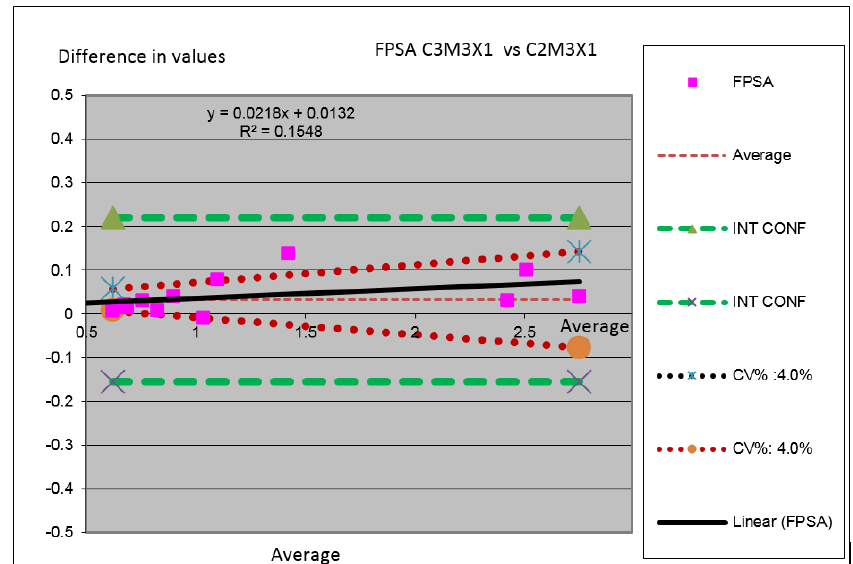
Figure 12. Comparison between modules for the Free Prostatic Specific Antigen (FPSA) parameter, in which we compared the results obtained by the measurements performed in the two machines (Analyzer C3 substituted by C2 in which the Module 3 is substituted by the Module M3 and the Channel X1 is substituted by the Channel